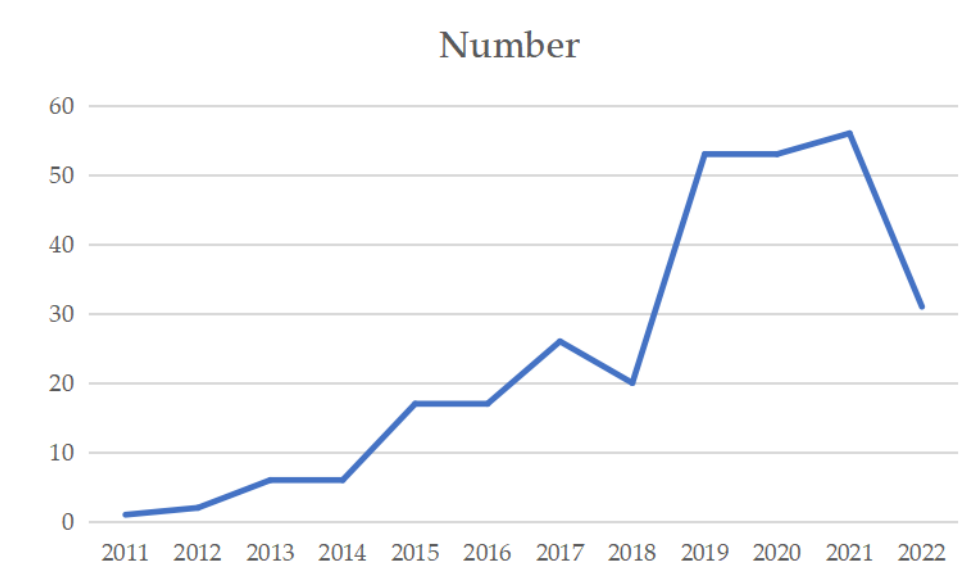
Figure 3. Number of papers published.